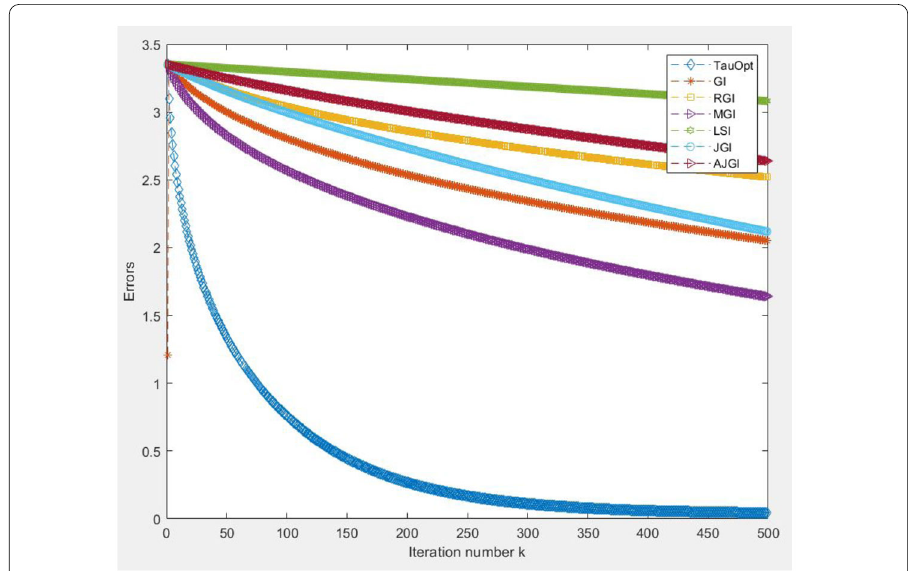
Figure 4 Errors for Example 6.2